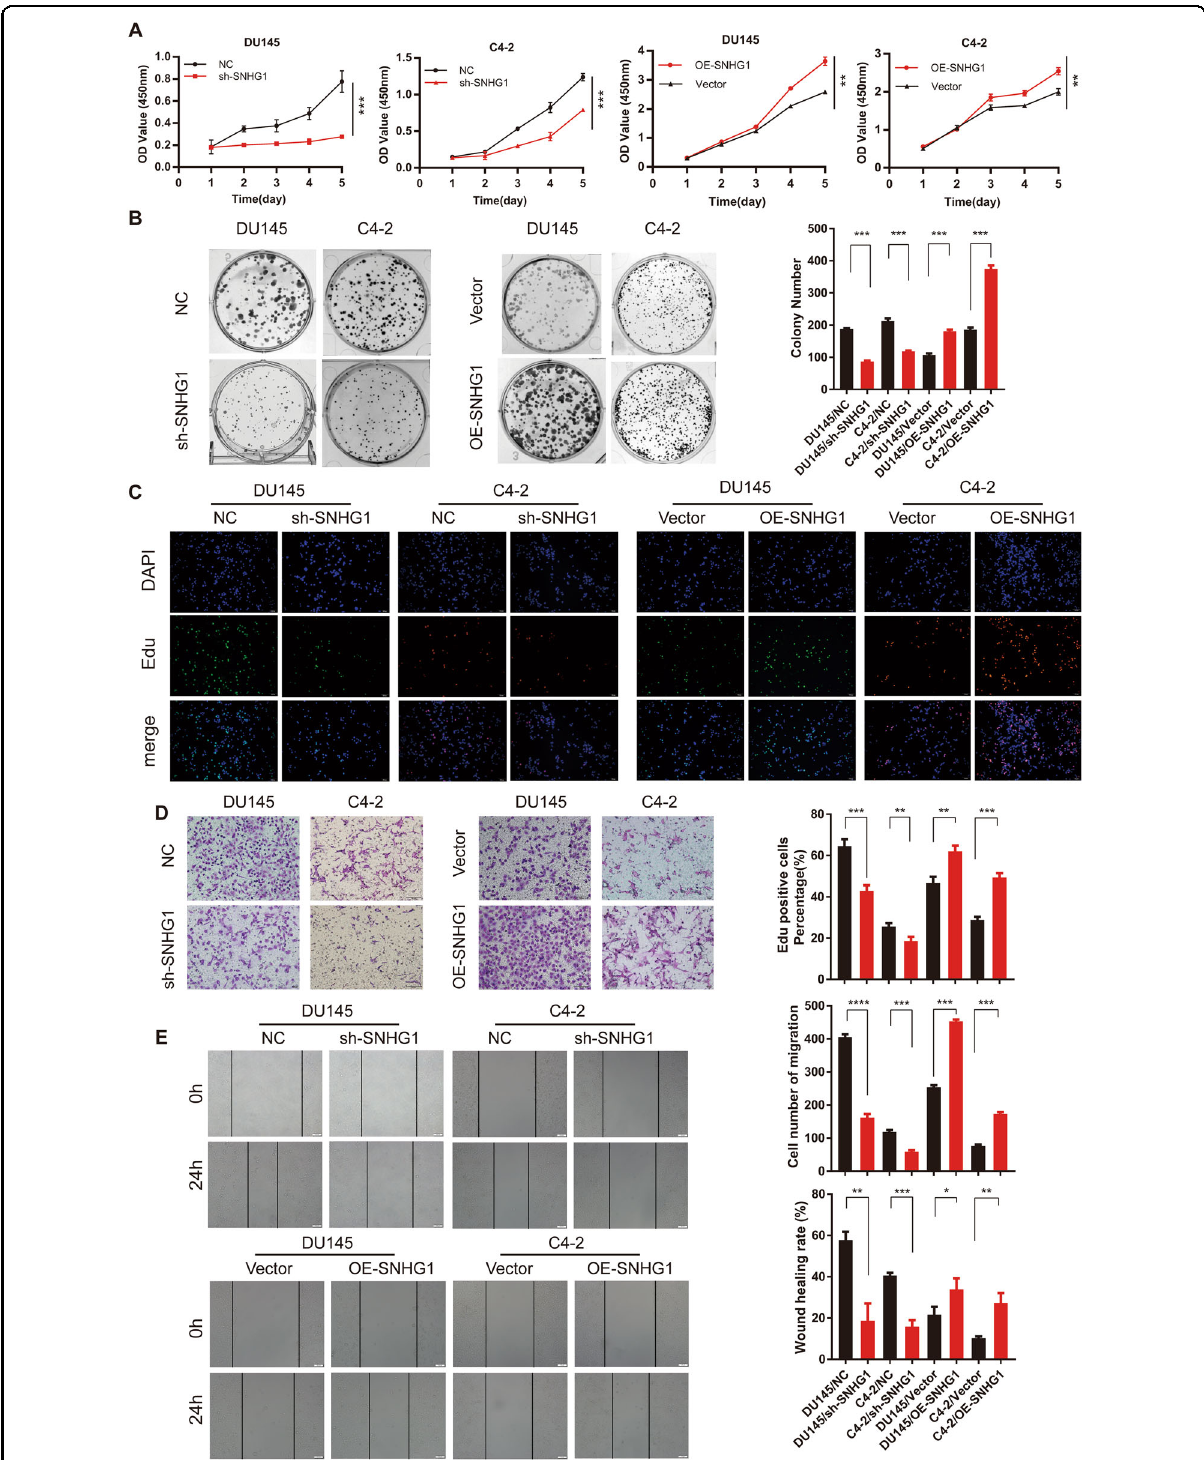
Fig. 2 LncRNA SNHG1 promotes PCa cell proliferation and migration in vitro. A, B CCK-8 assay and colony-formation assay were used to determine the proliferation ability of PCa cells by knocking down or overexpressing LncRNA SNHG1 . C EdU assays were used to determine the proliferation ability of PCa cells. D Transwell assays showed that SNHG1 knockdown or overexpression could inhibit or promote PCa cell migration. E SNHG1 knockdown attenuated cell migration in DU145 and C4-2 cells, while up-regulation of SNHG1 showed the opposite results. * P < 0.01, ** P < 0.01, *** P < 0.001, **** P <